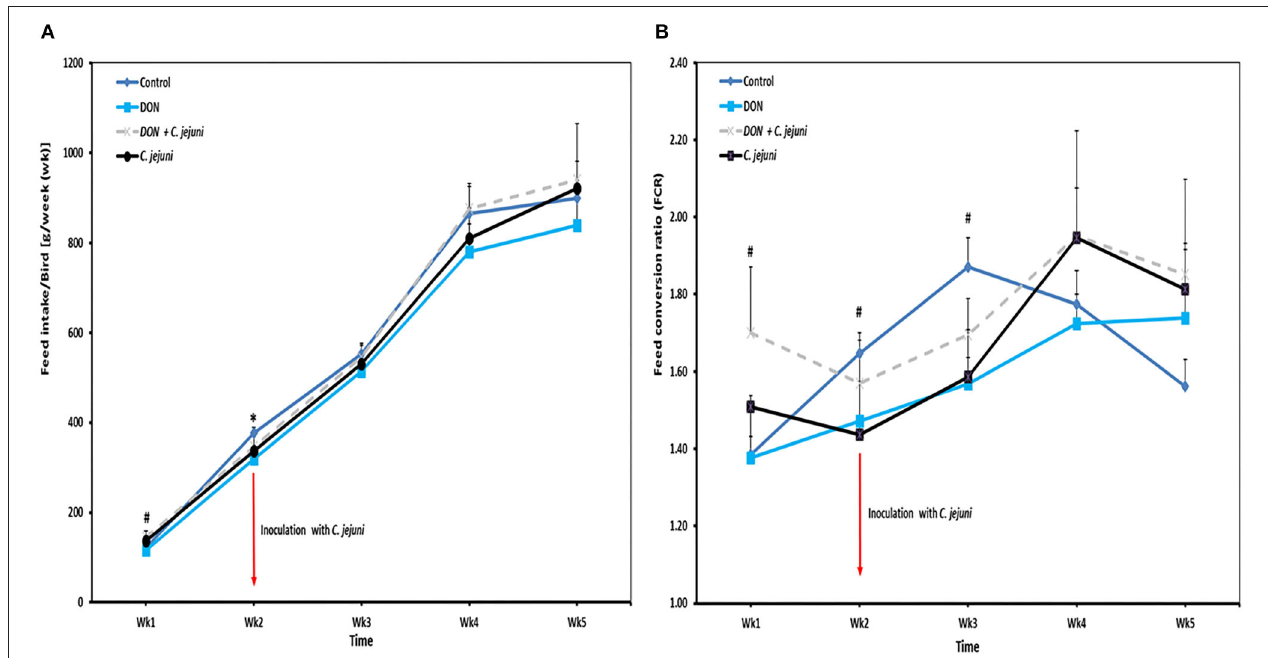
FIGURE 2 | Effect of DON and/or C. jejuni exposure on (A) feed intake (FI) and (B) feed conversion rate (FCR). Results are presented as mean and SEM. Asterisks mark differences with # P ≤ 0.1, or * P ≤